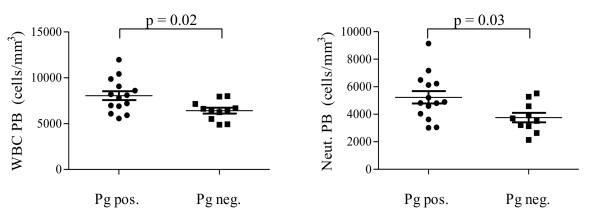
White blood and blood neutrophils count positivity for Porphyromonas gingivalis in the subgingival plaque. Blood cell count according to Porphyromonas gingivalis positivity in the sub-gingival plaque of RA patients. Pb, peripheral blood; Pg, Porphyromonas gingivalis; Neut., neutrophils; WBC, white blood cells.